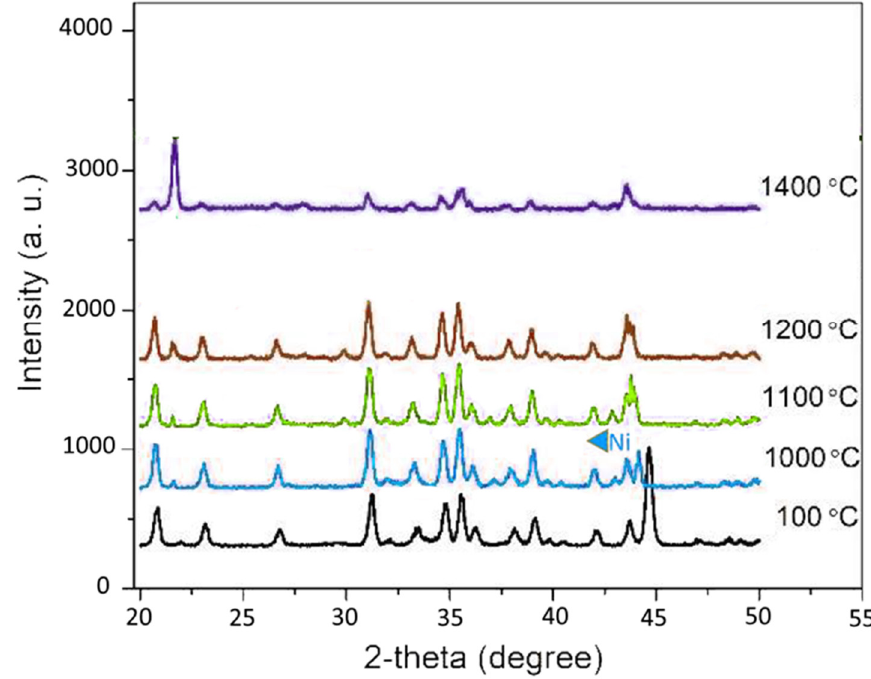
Figure 8. XRD pattern of 30 wt%Ni/Ca-α-SiAlON at different sintering temperatures.